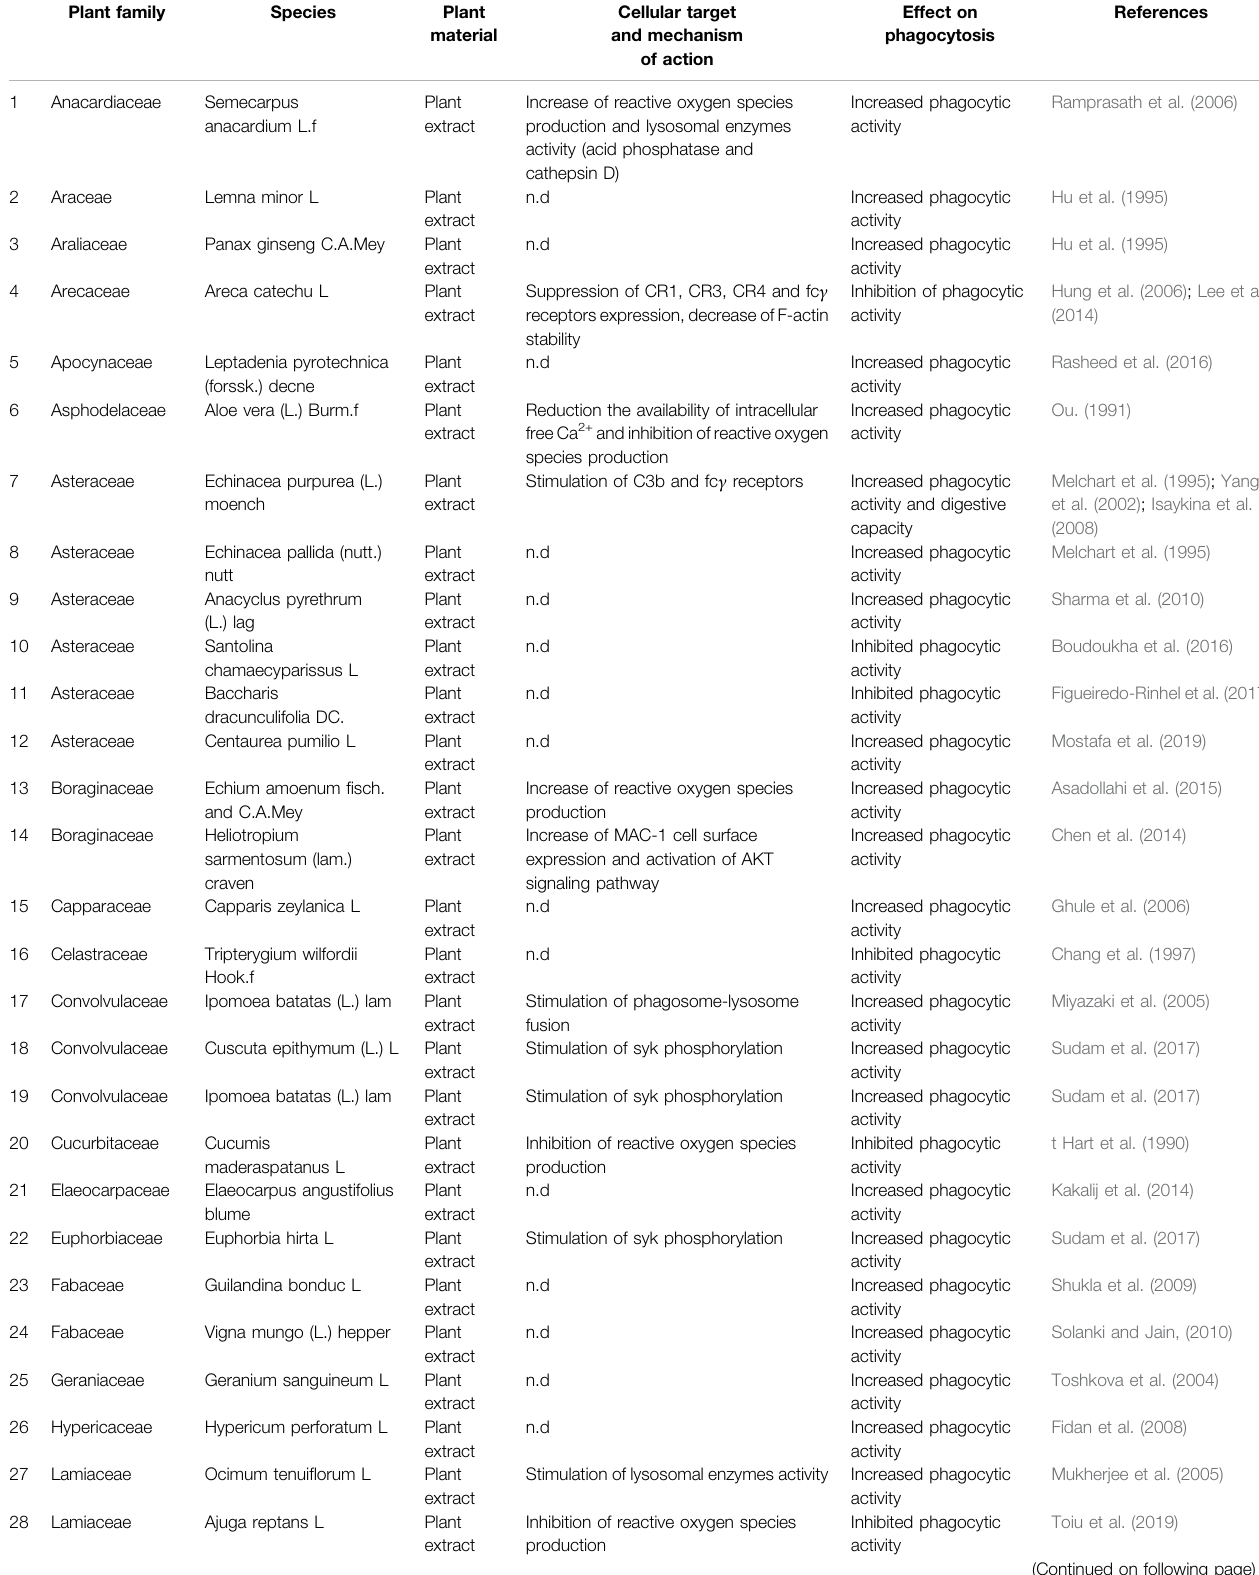
TABLE 1 | List of selected plant material with documented impact on phagocytosis. Plant